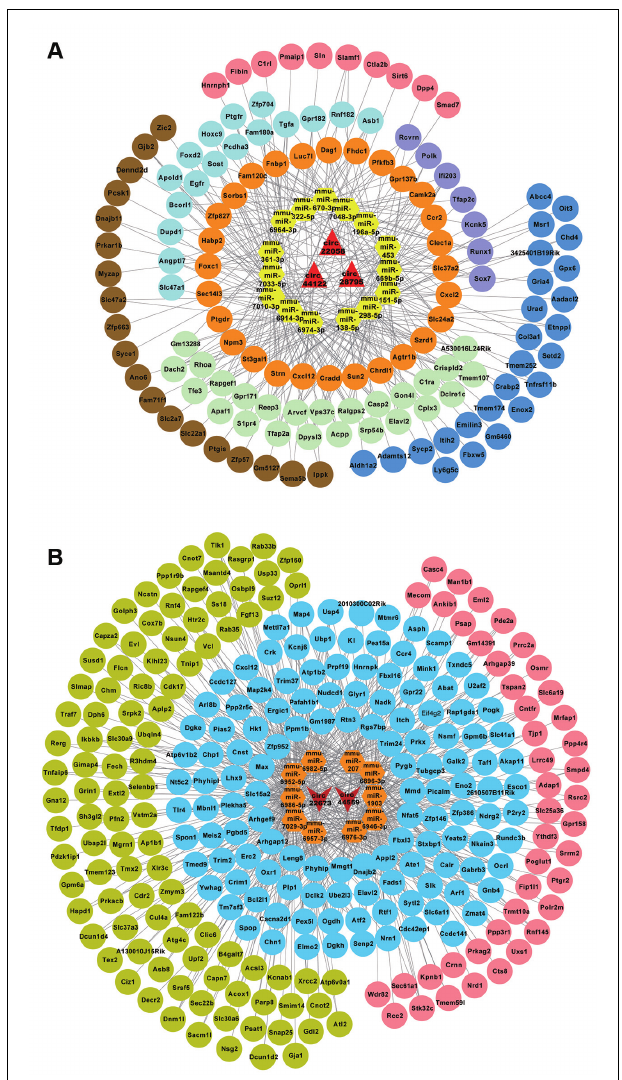
FIGURE 4 | circRNA-miRNA-mRNA network analysis. (A) The ceRNA network for the three upregulated circRNAs. (B) The ceRNA network for the three downregulated